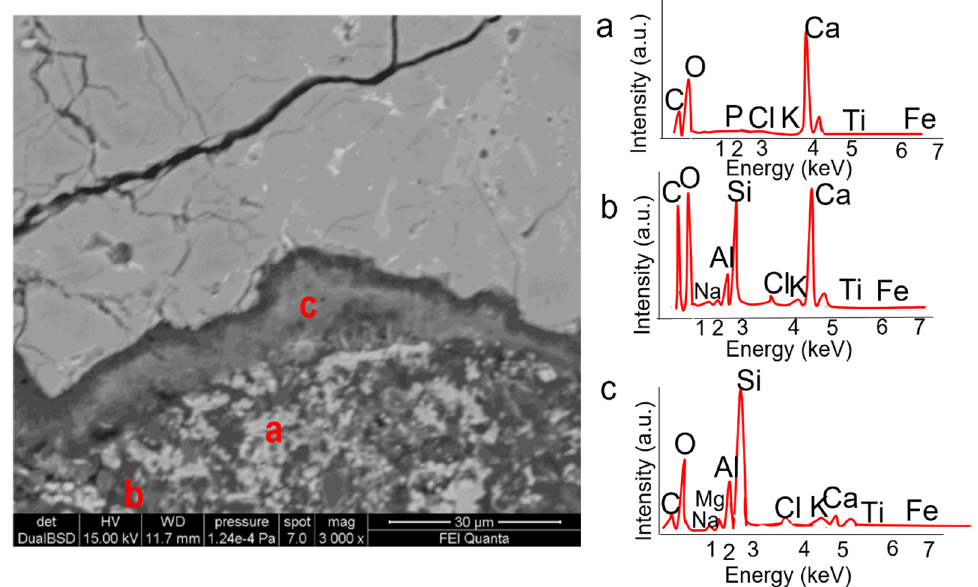
Figure 14. BSE image and EDS spectra of binder components ( a , b ) and reaction edge between quartz crystal and binder ( c ). Table 4. Main mineralogical phases in the pumices (P1, P2, P3), travertine (T1), limestone (L1,